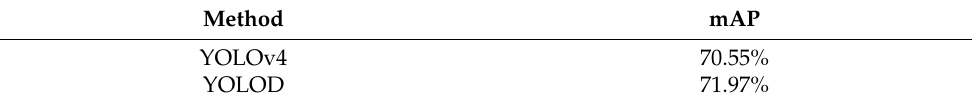
Table 8. Results of training on the forklift